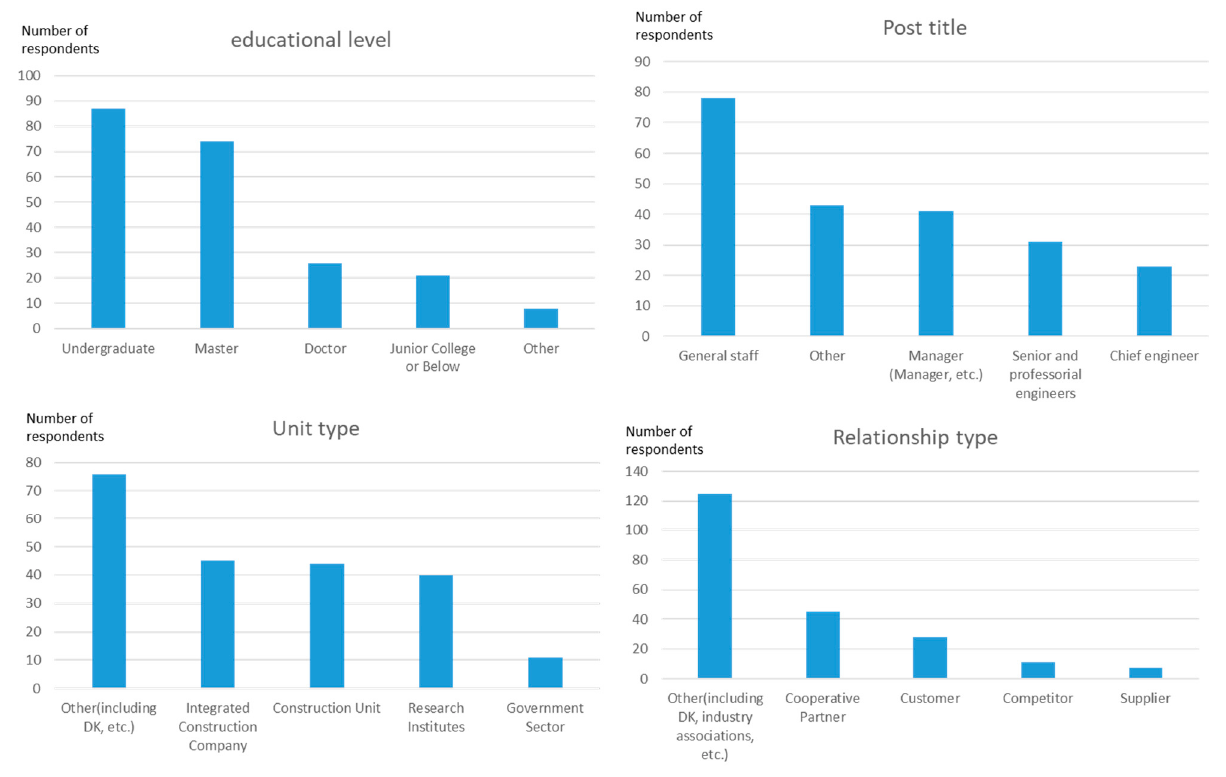
Figure 8. Number of respondents according to the level of education, post title, unit type and relationship type.